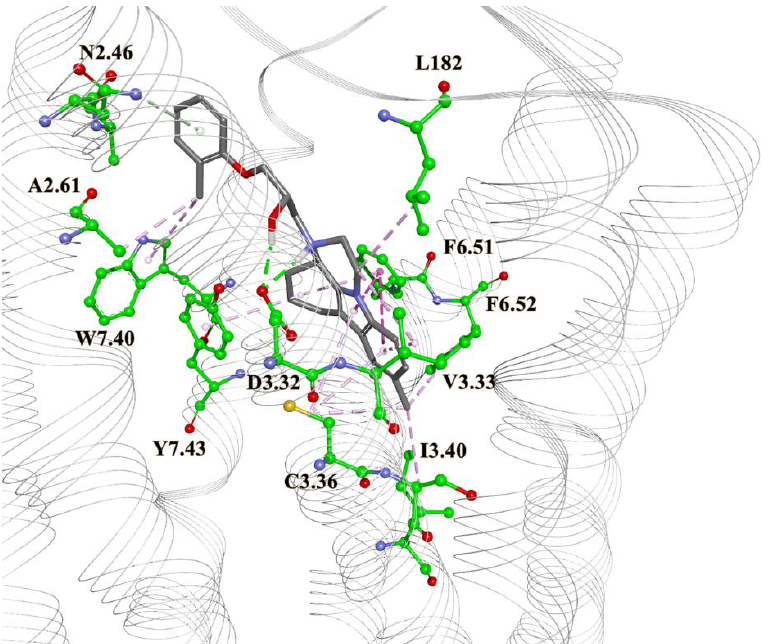
Figure 4. Homology model of 5HT6 receptor with docked best candidate compound ZINC00756618 and interacting AA residues. Green lines: hydrogen bonds; purple: aromatic interactions; grey: hydrophobic interactions; orange: anion—PI interaction.